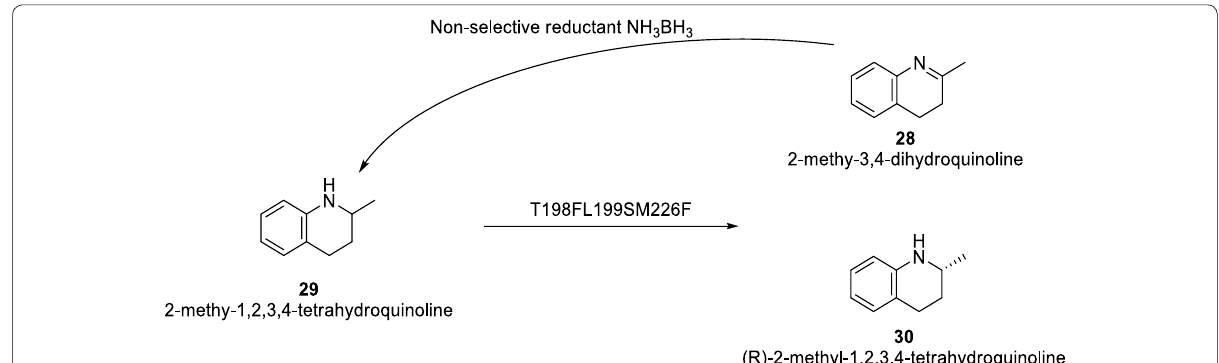
Fig. 9 Deracemization of 2-methyl-1,2,3,4-tetrahydroquinoline using triple variant T198F/L199S/M226F and chemical reductant